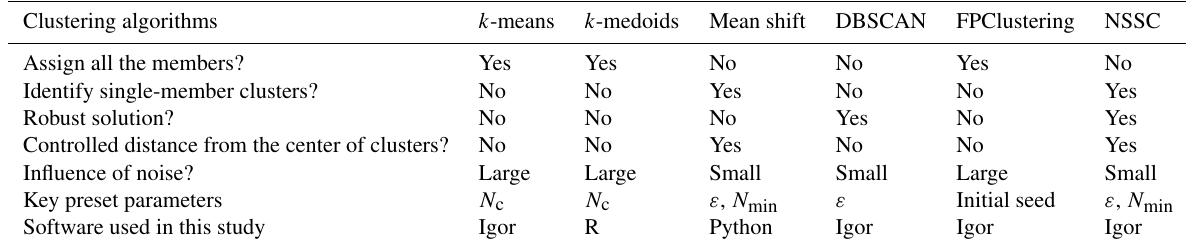
Table 2. Comparison of different clustering algorithms. Clustering algorithms k